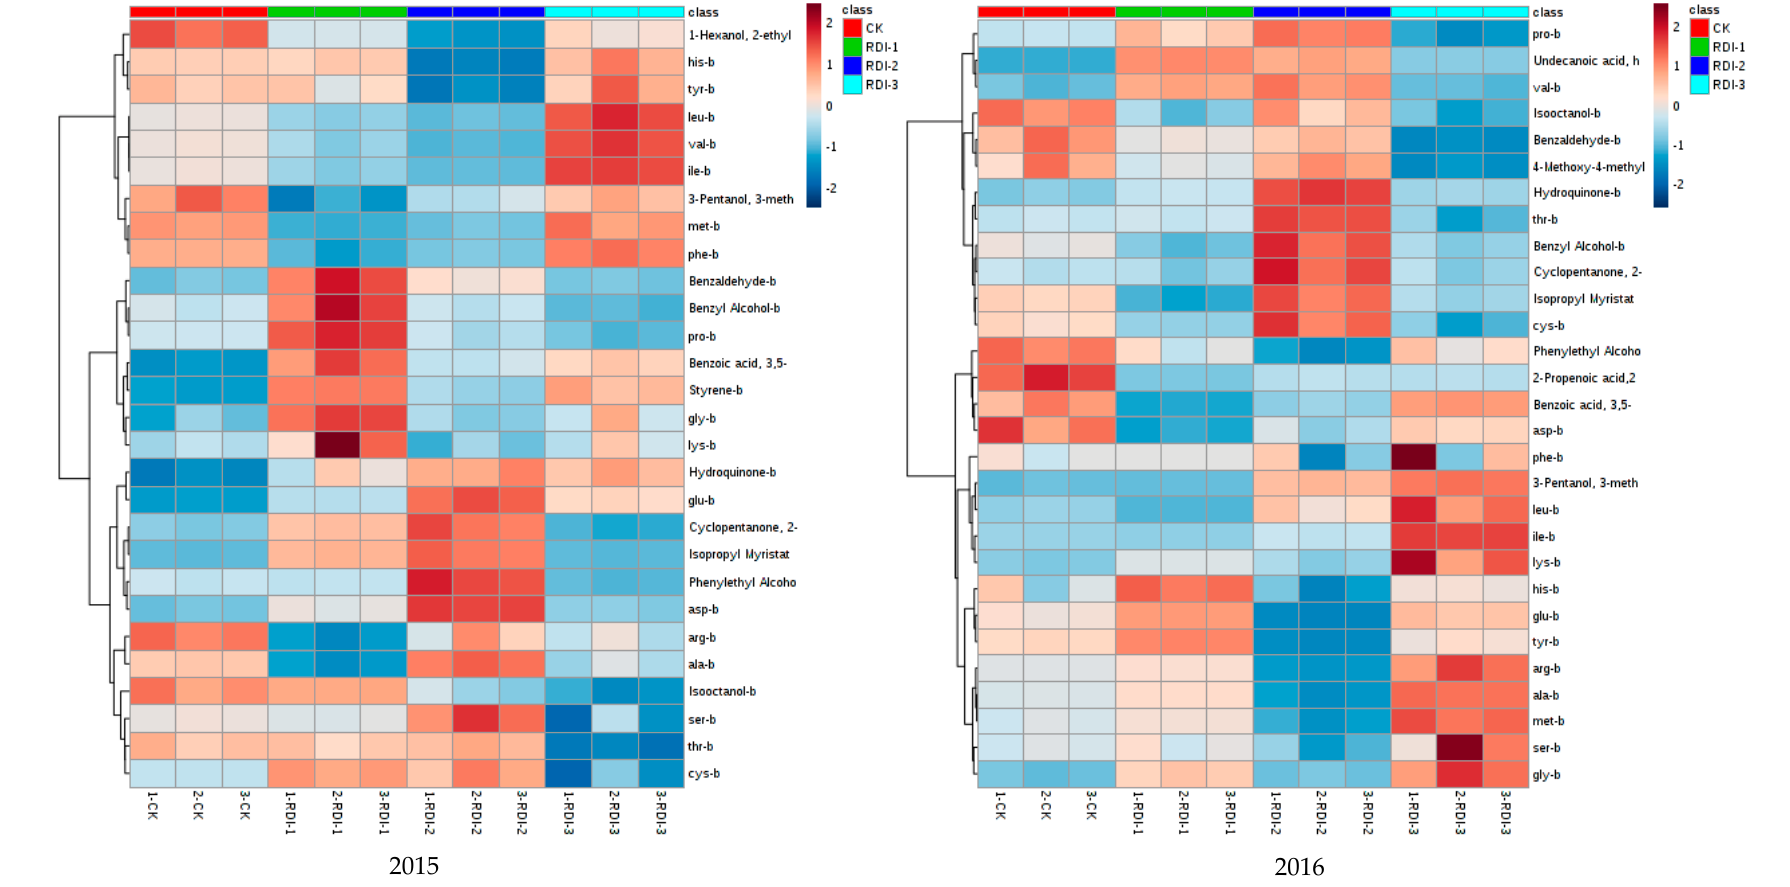
Figure 1. Clustered heatmaps of amino acids and volatile compounds derived from grape berries subjected to different treatments. Data were normalized by a pooled sample from the control group.